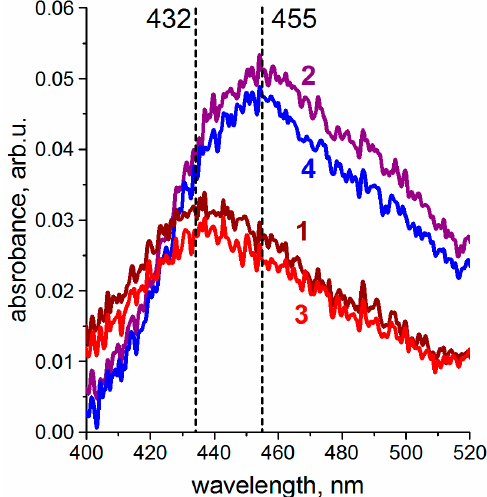
Figure 10. NiTPP Soret band upon lateral compression and expansion of NiTPP × CRPcRu(pyz) 2 mixed monolayer. Presented spectra correspond to the first cycle of lateral compression from mean molecular area of (1) 220 Å 2 to (2) 60 Å 2 , (3) monolayer expansion to 220 Å 2 , and (4) another compression to 60 Å 2 .